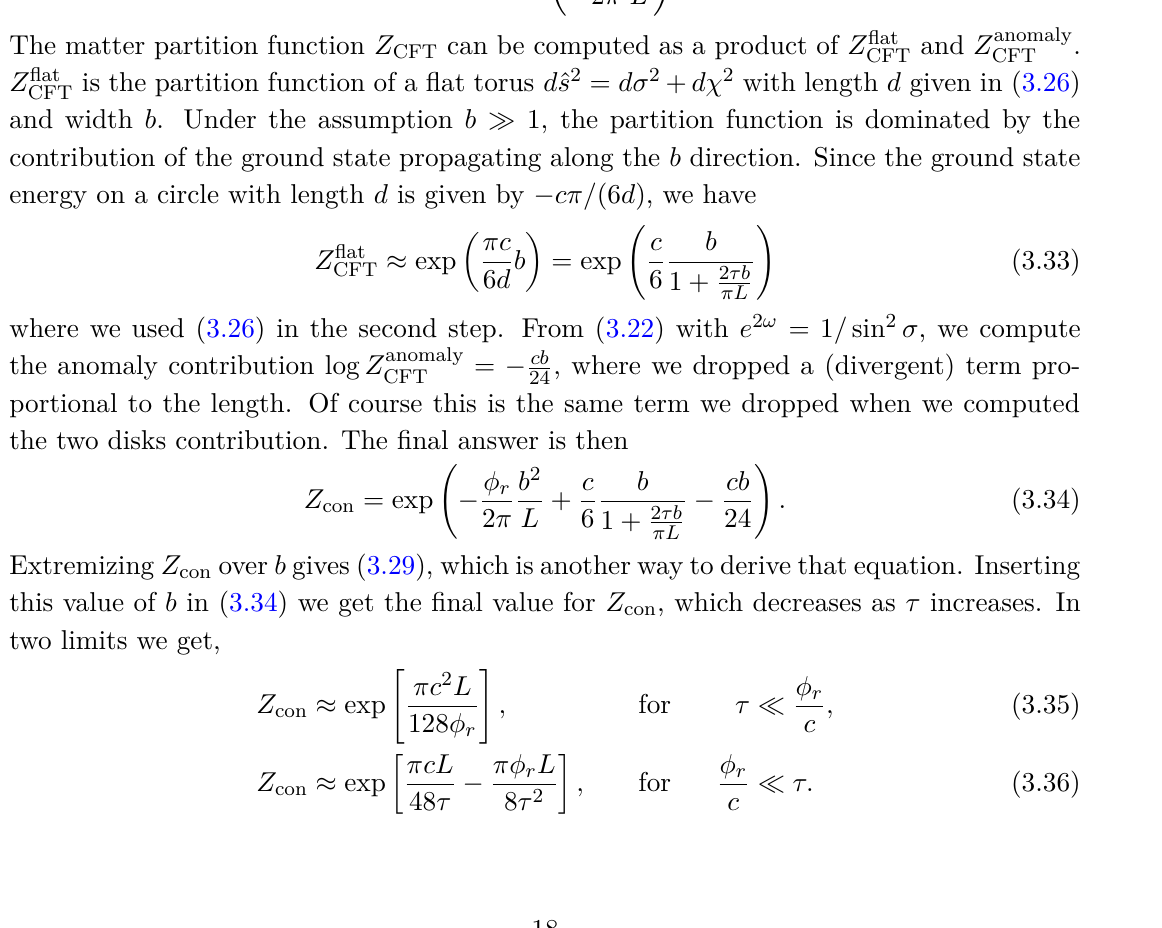
Figure 10 . (a) We plot the behavior of bφ r also plotted the two approximate expressions in (3.30) and (3.31). (b) We plot the minimal values of L in order for the wormhole to dominate, as a function of τc L c wormhole phase. We also plotted the approximate expression in (3.38) when τ (cid:29) φ r /c